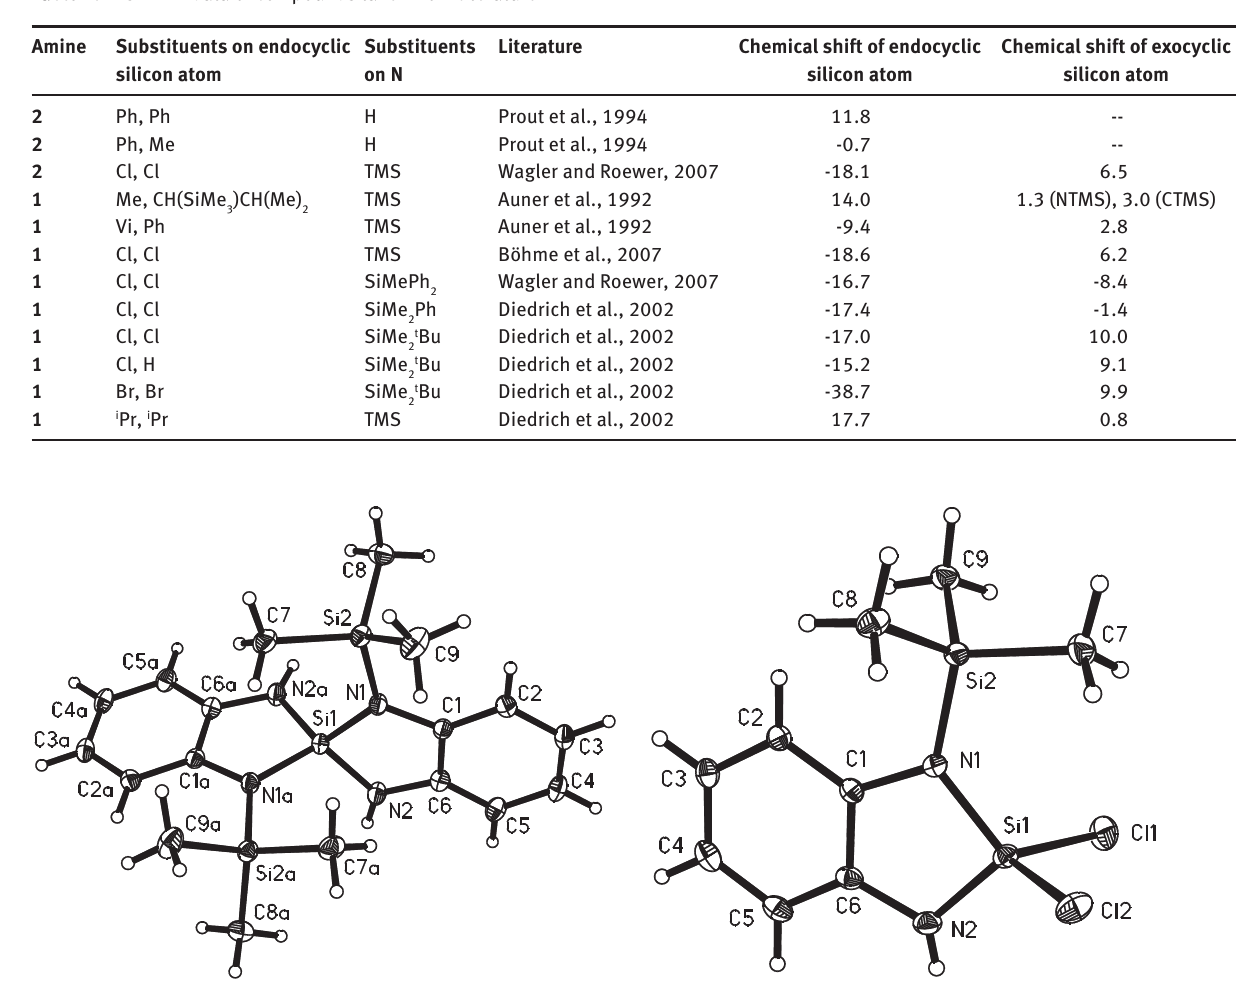
Figure 4: Molecular structure of 2d-TMS including numbering scheme. The thermal displacement ellipsoids of the non-hydrogen atoms are drawn at the 50% probability level.